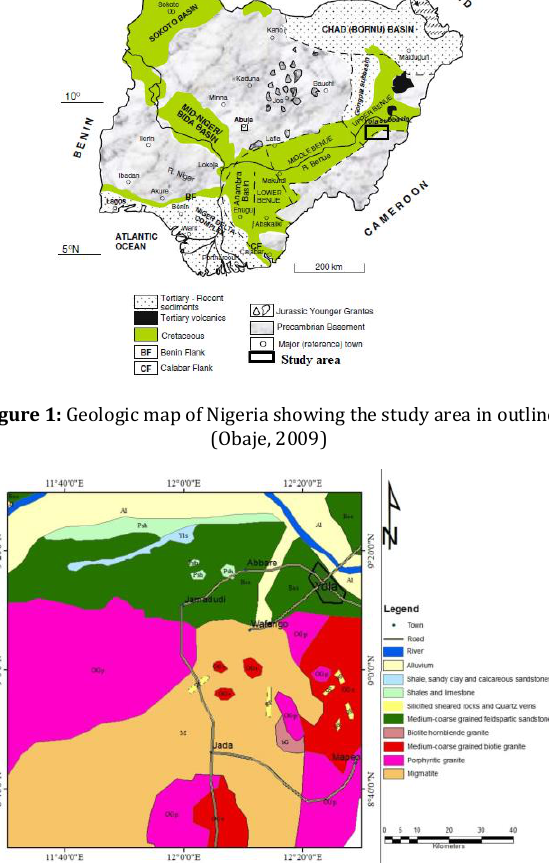
Figure 2: Geologic map of the study